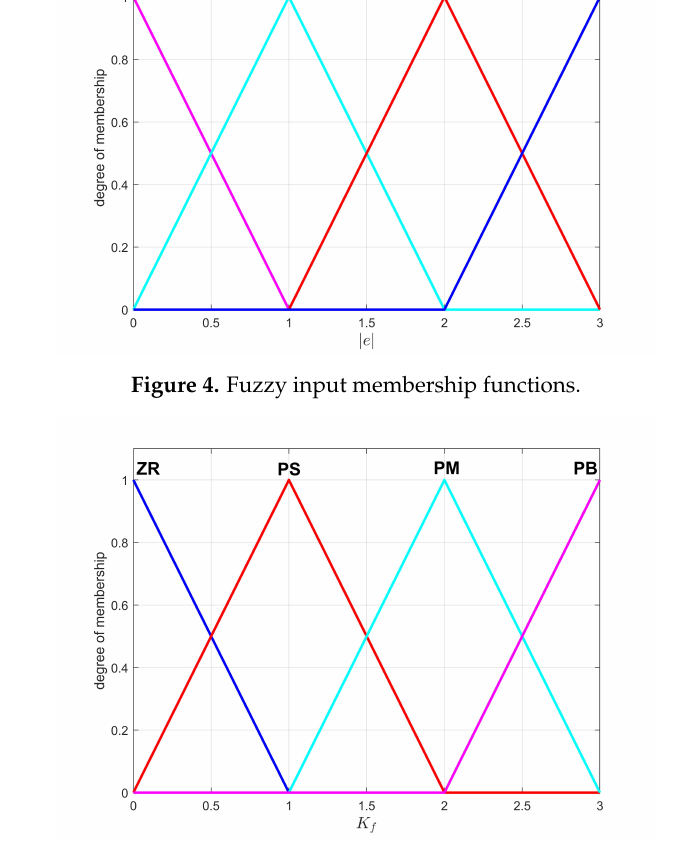
Figure 5. Fuzzy output membership